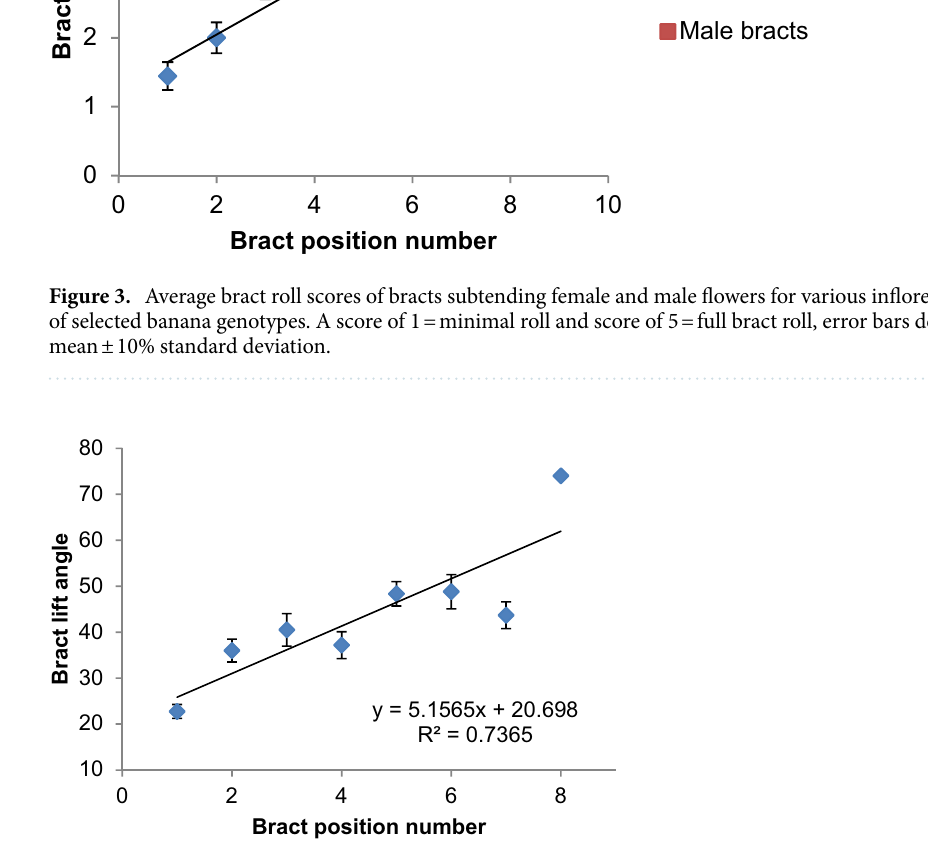
Figure 4. Average bract lift angle of bracts subtending female flowers for different bract positions of 9 selected banana genotypes, error bars denote mean ± 10% standard